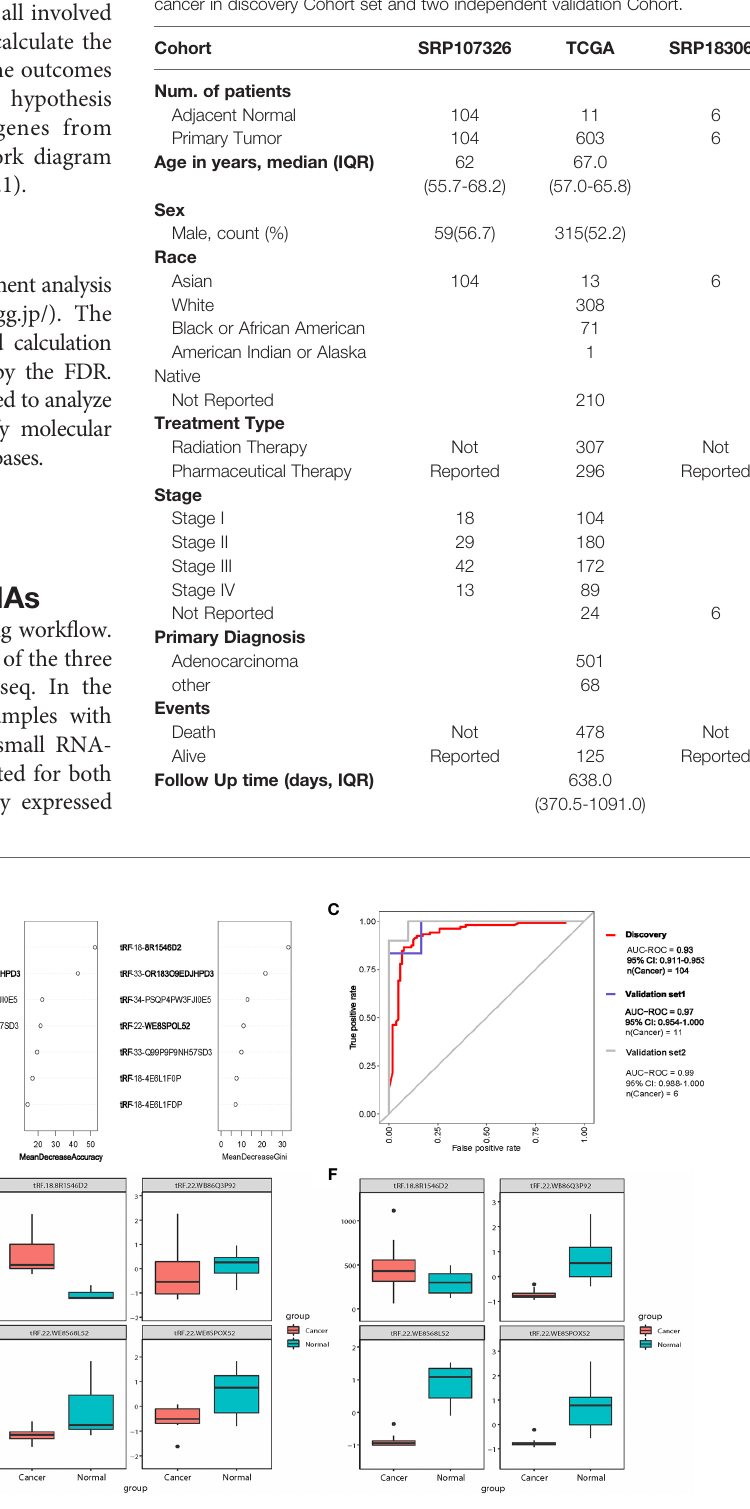
TABLE 1 | Demographic and clinical characteristic of patients with Colorectal cancer in discovery Cohort set and two independent validation Cohort.